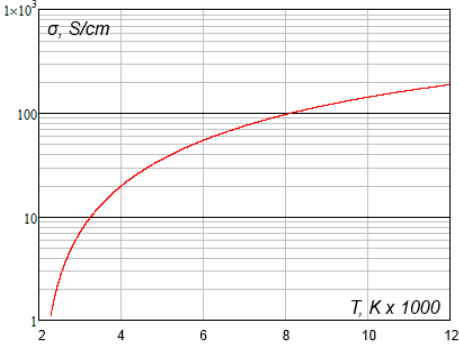
Figure 15. Plasma conductivity as a function of temperature.